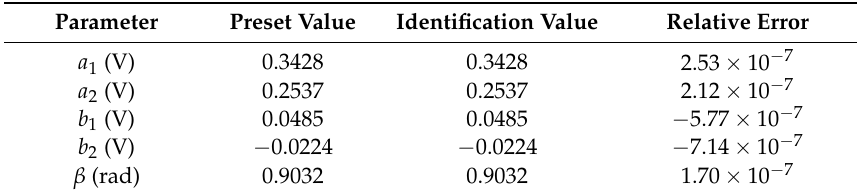
Table 1. Parameter estimation results obtained from the simulation.